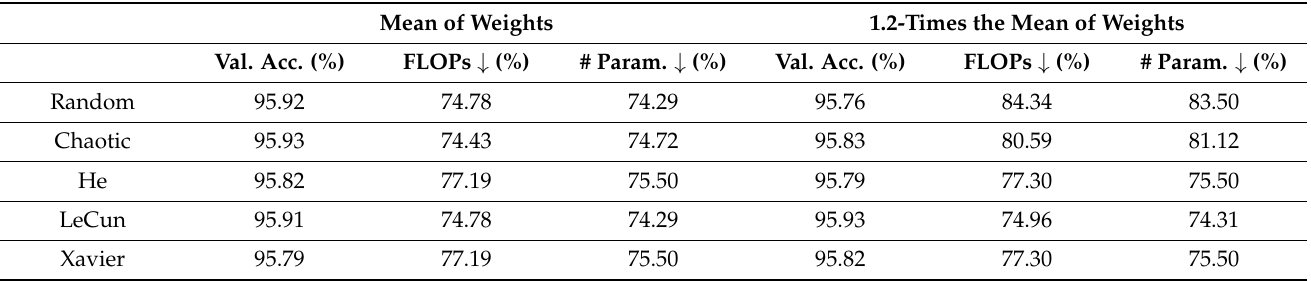
Table 8. Pruning results for TernausNet on Inria dataset under various threshold values. Mean of